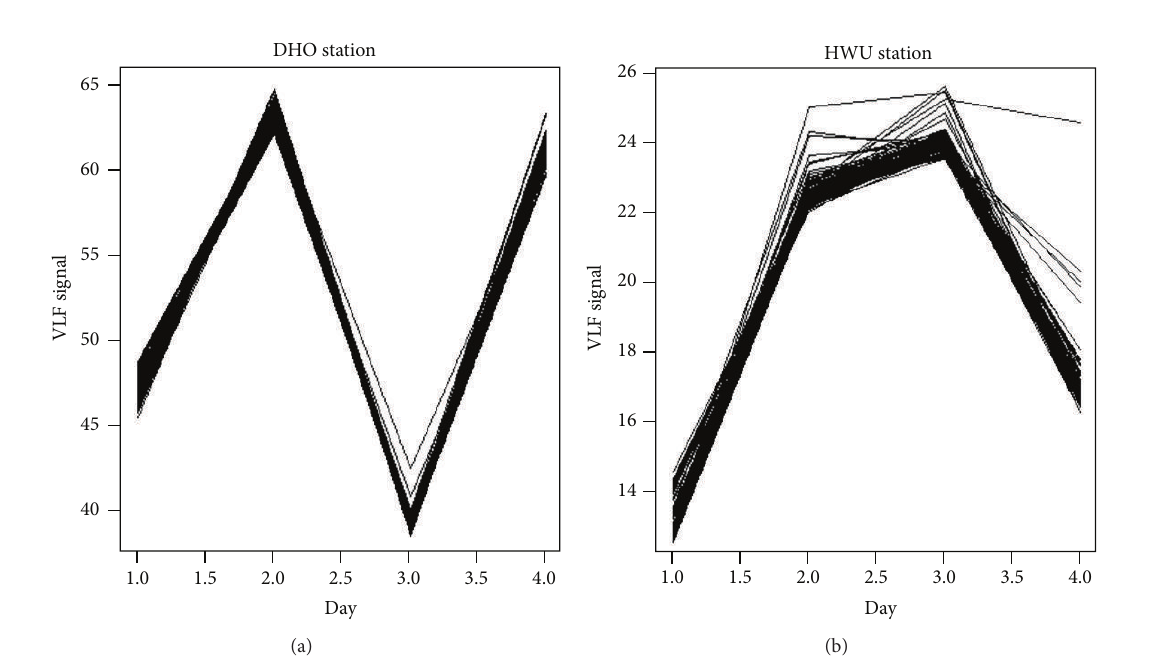
Figure 2: Spaghetti plots of VLF signals for the two stations.